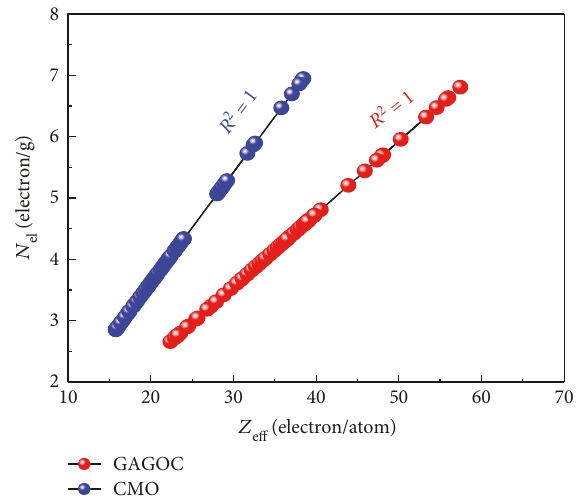
Figure 6: Correlation between e ff ective atomic number ( Z electron density ( N